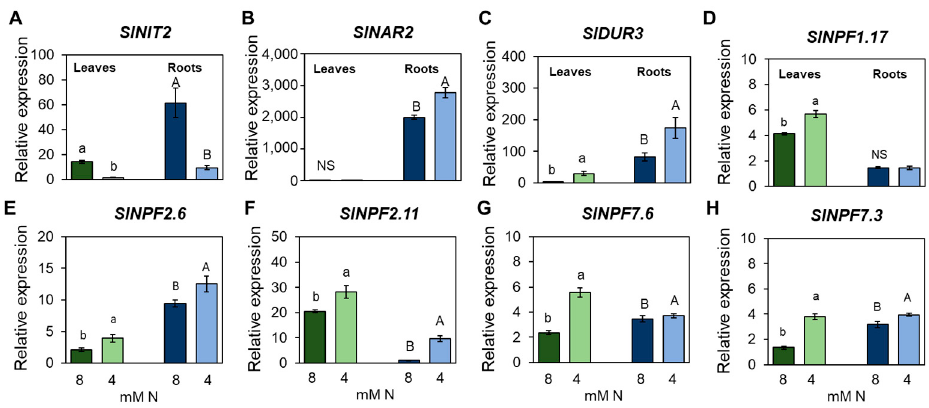
Figure 5. Changes in the relative expression of nitrogen compound transporters with different ni- trogen supplies. mRNA levels of SlNIT2 ( A ), SlNAR2 ( B ), SlDUR3 ( C ), SlNPF1.17 ( D ), SlNPF2.6 ( E ), SlNPF2.11 ( F ), SlNPF7.6 ( G ), and SlNPF7.3 ( H ) genes in leaves and roots under optimal (8 mM N, dark colored bars) and suboptimal (4 mM N, light colored bars) conditions. Each value (±SE) is the mean of three different determinations. For each organ, different letters indicate significant differ- ences ( p < 0.05).